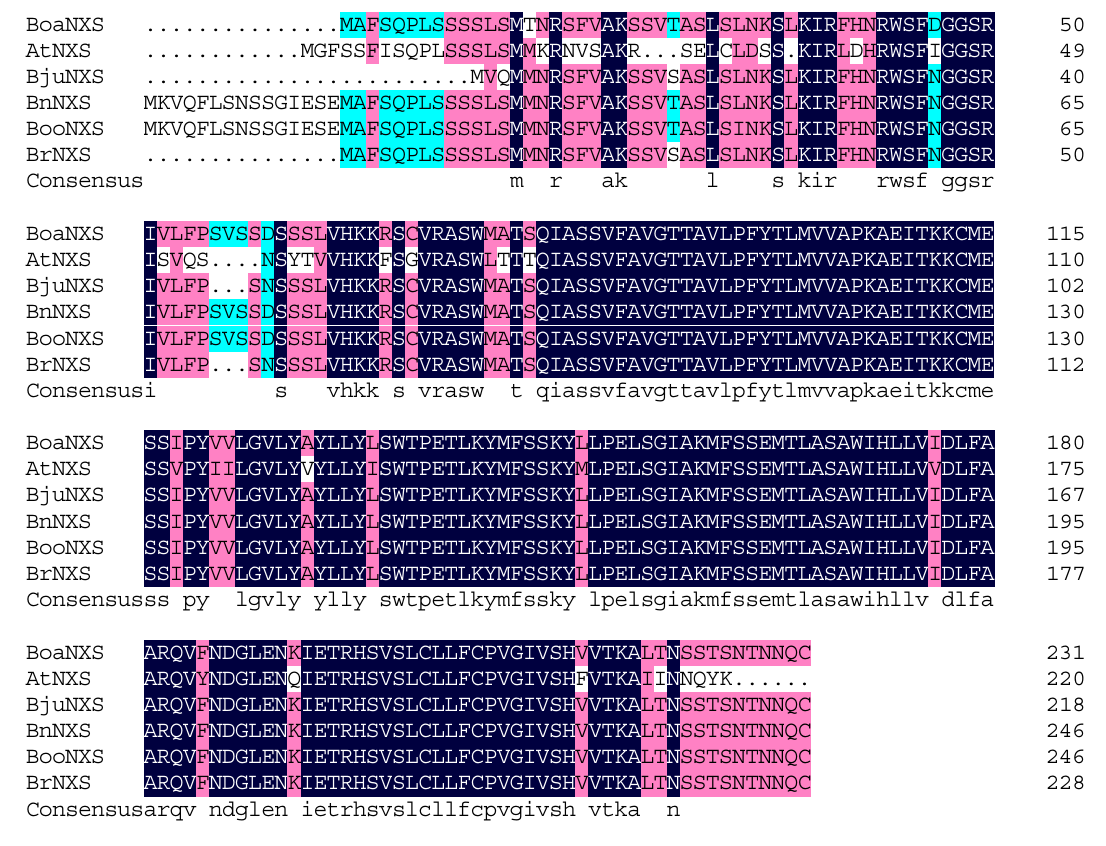
Figure 1. Multiple sequence alignment of NXS from different plants. Alignment of the protein sequence of BoaNXS with selected homologs. The alignment was performed using DNAMAN software. The amino acids with 100% identity are shown with a black background, those with ≥ 75% identity are shown in red, and those with ≥ 50% identity are shown in blue. The species and their accession numbers in GenBank ( Brassica oleracea var. alboglabra (Boa): BoaNXS (MW284390), Arabidopsis thaliana (At): AtNXS (VYS50248.1), Brassica juncea (Bju): BjuNXS (BjuA007212), Brassica napus (Bn): BnNXS (XP_013676374.1), Brassica oleracea var. oleracea (Boo): BooNXS (XP_013618475.1), Brassica rapa (Br): BrNXS (XP_009127521.1) are listed here.